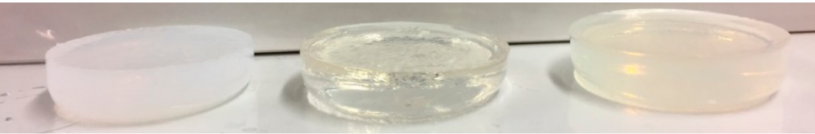
Figure 4. Image of the hydrogels: PAA1.5 (left); PAA/PVSA1.5 (middle); PAA/PSSA-MA1.5 (right).